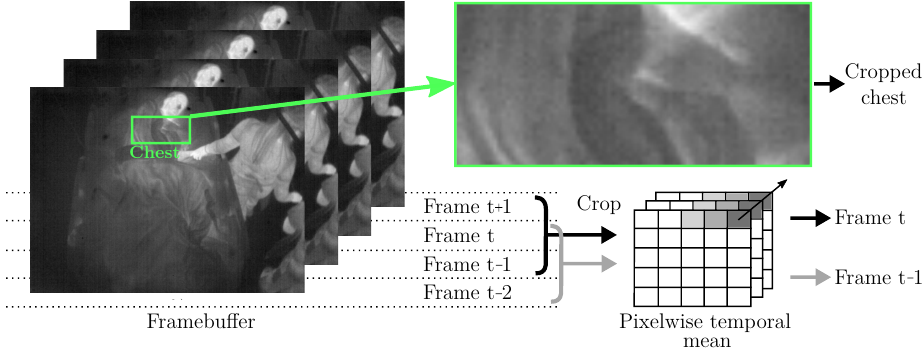
Figure 8. Temporal filtering as preprocessing for Farnebäck’s OF algorithm. The OF algorithm (Figure 7a) returned the displacement field, i.e., the motion of each pixel in the chest region as visualized by red arrows in “Optical Flow”, Figure 7. All dis- placement vectors were spatially averaged (Figure 7b) to extract the mean motion of the chest. This “Raw Signal” (Figure 7c) was filtered using a 2nd-order Butterworth bandpass filter with breathing-related cutoff frequencies of 0.15 Hz and 0.44 Hz. Next, the auto- correlation of the filtered signal was computed to quantify the signal’s